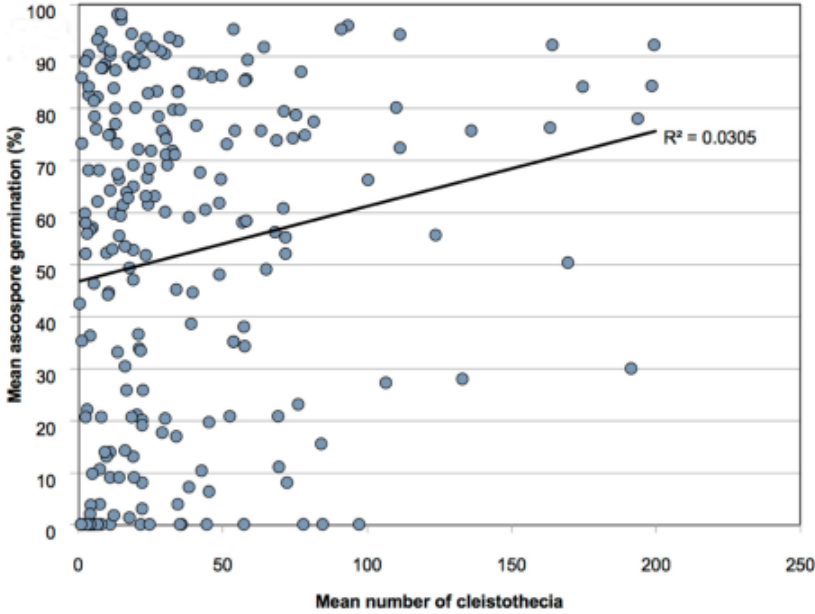
Figure 5. Relationship between the number of cleistothecia formed in crosses of A. fumigatus and germination rate of ascospores from the respective cleistothecia. R 2 = coe ffi cient of